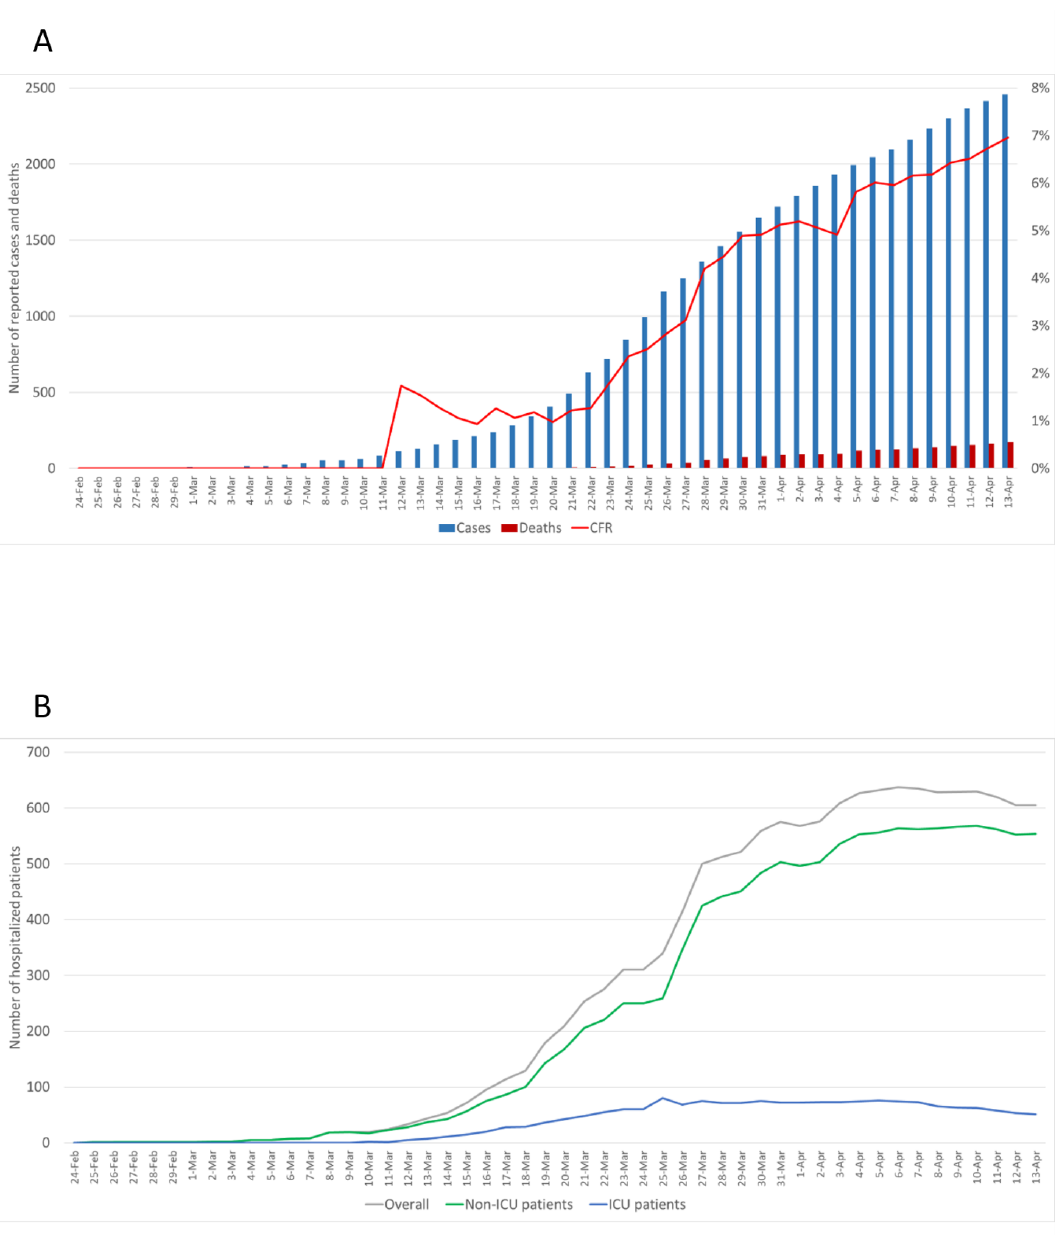
Figure 2. Number of cases, hospitalized patients and deaths in Sicily, Italy, reported by Italy’s Civil Protection from 24 February 2020 to 13 April 2020. ( A ) The bars represent the cumulative number of reported SARS-CoV-2 cases and related deaths while the red line represents the case fatality risk (CFR). ( B ) The grey line represents the daily number of hospitalized patients, while blue and green lines represent the daily number of patients hospitalized in Intensive Care Unit (ICU) or in other wards.